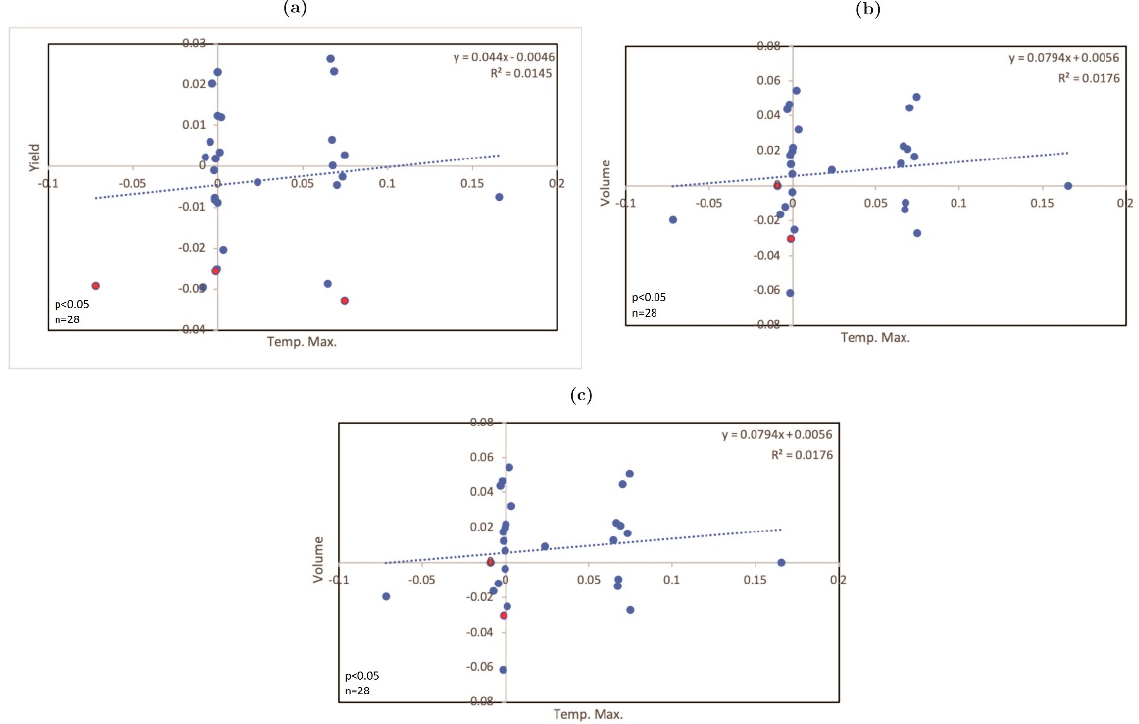
Figure 7. Dispersion behavior of average values for the maximum temperature and the analysis variables. ( a ) Maximum temperature vs. corn crop yield, ( b ) maximum temperature vs. livestock cattle production volume, and ( c ) maximum temperature vs. livestock cattle weight. The red points indicate the municipalities with a 95% statistical significance level.